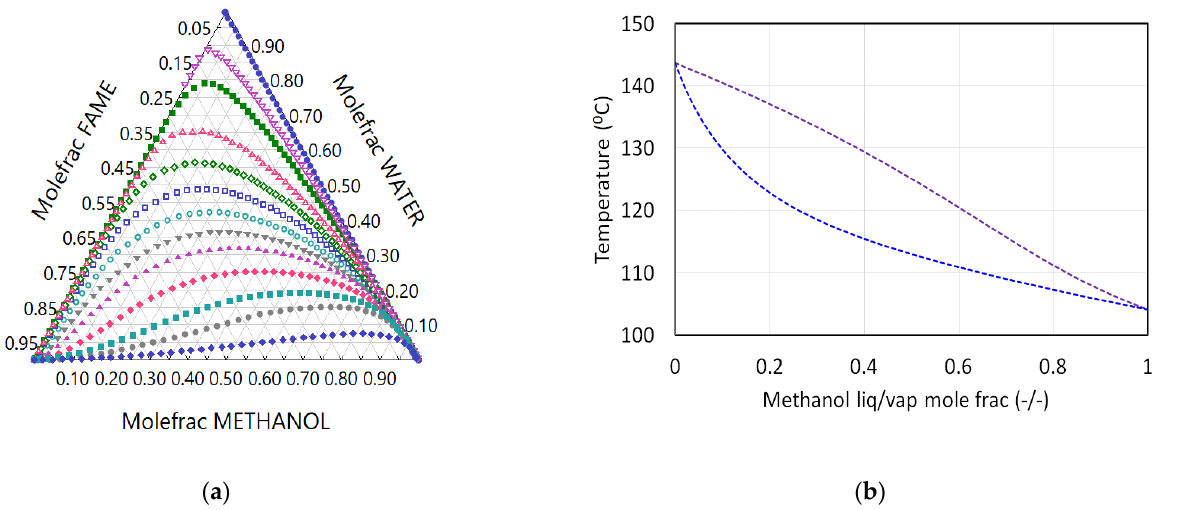
Figure 1. Thermodynamic relations. ( a ) Residue curve for FAME–Methanol–Water. ( b ) T-xy diagram for methanol–water. Table 1. Binary parameters of UNIQUAC activity model.